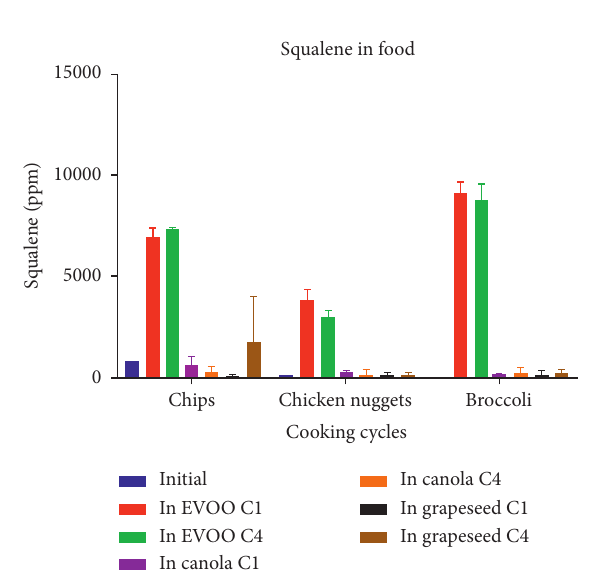
Figure 3: Squalene in the food